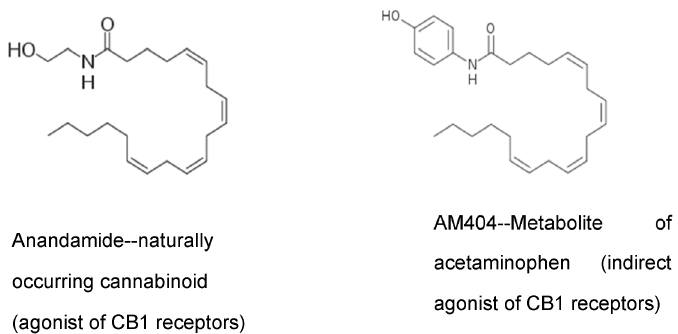
Figure 5. Chemical structure similarity between anandamide and acetaminophen metabolite AM404. Modified from https://commons.wikimedia.org/wiki/File:Anandamide_skeletal.svg (accessed